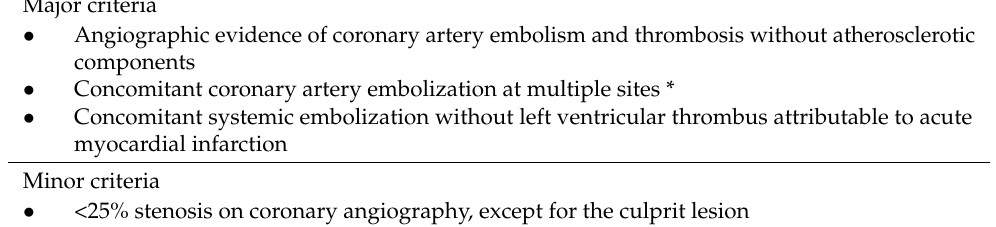
Table 2. Coronary embolism diagnostic